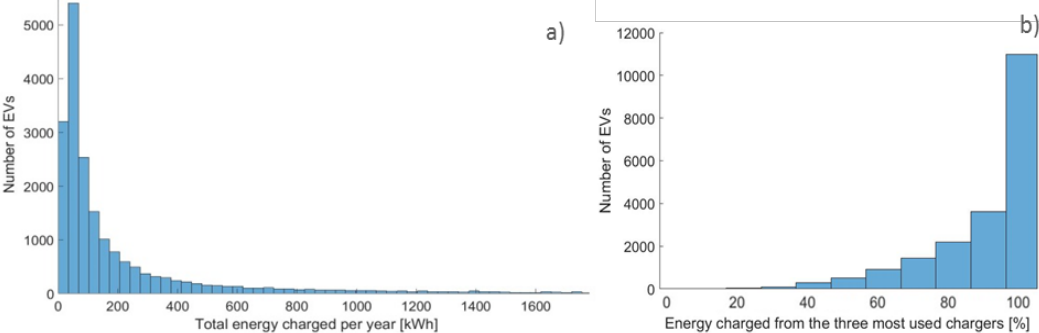
Figure 1. Total yearly energy charged by electric vehicles (EVs) ( a ) and percentage of energy drawn from the three most used chargers ( b ).